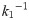
Mean, standard deviation (sd), and coefficient of variation (cv) of the transcription intervals when varying each parameter independently around the parameter values found for the Plac/ara-1 promoter, full induction.The numeric labels for the crosses indicate temperature (°C). The data points are derived from the best fitting model. The curves for k1-1 correspond to those shown in S4 Fig. The curve for kon-1 is close to that of k1-1, k1-1, and k2-1 for mean, sd, and cv, respectively. The curve for k3-1 is similar to that of k2-1 in all cases and is thus omitted.